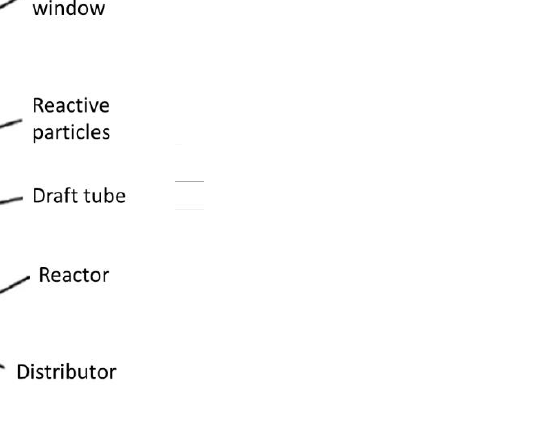
Figure 5. Scheme of a solar-driven fluidized-bed reactor with internal particles circulation.